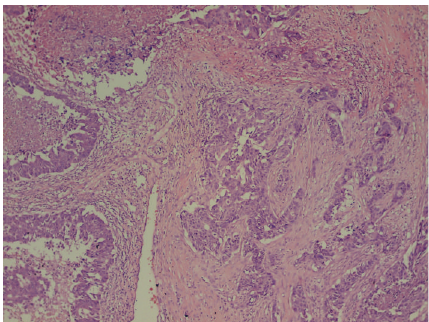
Figure 1: Larger tumour: conventional invasive ductal carcinoma of histological grade 3, with extensive necrosis and marked desmo- plastic stromal reaction (hematoxylin-eosin stain, × 40).